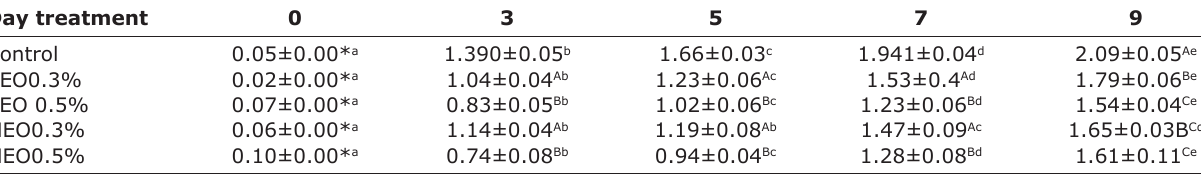
Table-4: PVs of minced beef containing different levels of ZEOs and MEOs during 9 days of storage at 7°C. Day treatment 0